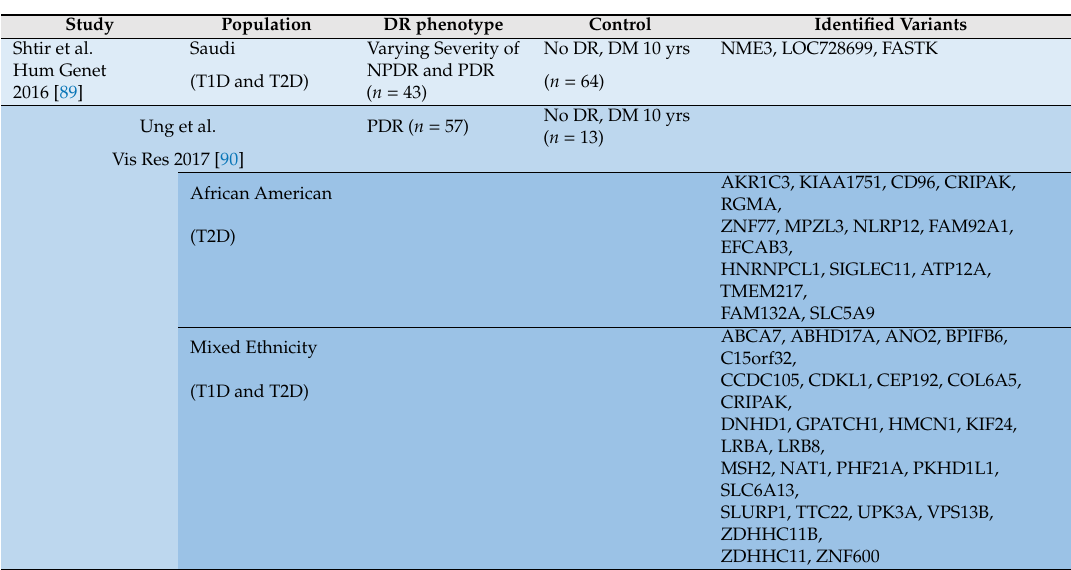
Table 3. Whole Exome Sequencing Studies of Diabetic